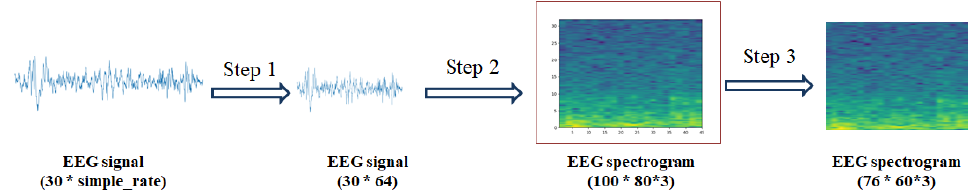
Algorithm 1 The description of EEG spectrogram produce.